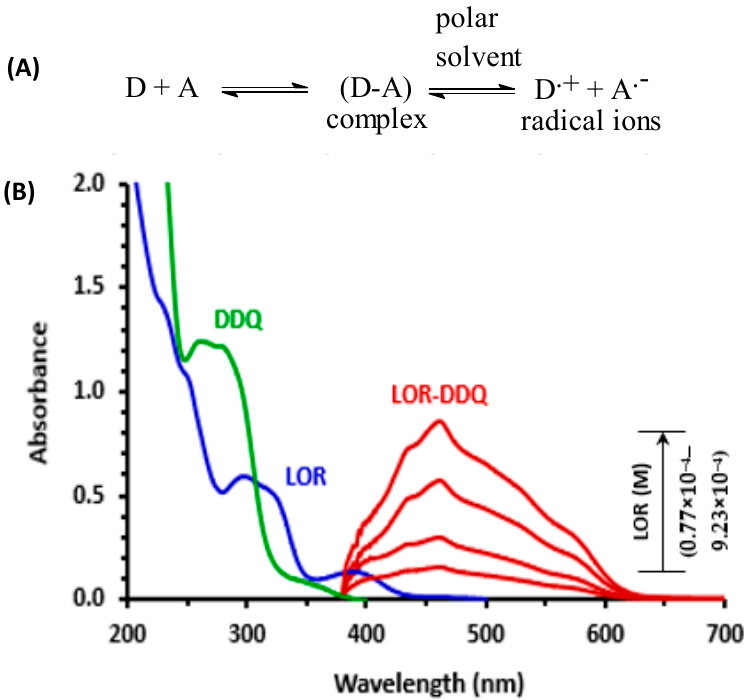
Figure 1. Panel ( A ): CT reaction between donor (D) and acceptor (A). Panel ( B ): Absorption spectra of lorlatinib, LOR (4.92 × 10 − 4 M), 2,3-dichloro-3,5-dicyano-1,4-benzoquinone, DDQ (5.51 × 10 − 3 M), and reaction mixtures (LOR-DDQ) containing varying concentrations of LOR (0.77 × 10 − 4 M–9.23 × 10 − 4 M) and a fi xed concentration of DDQ (5.51 × 10 − 3 M); all solutions were in methanol.